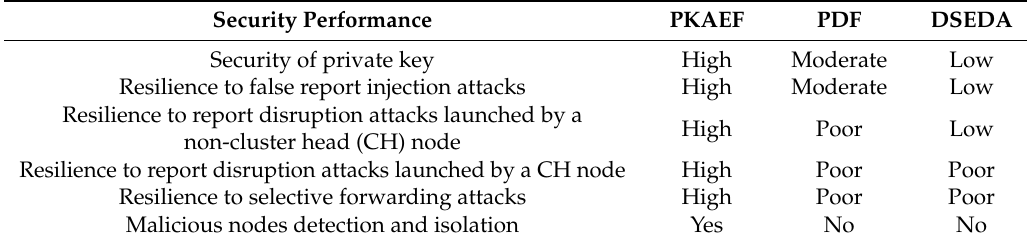
Table 1. Comparison of security